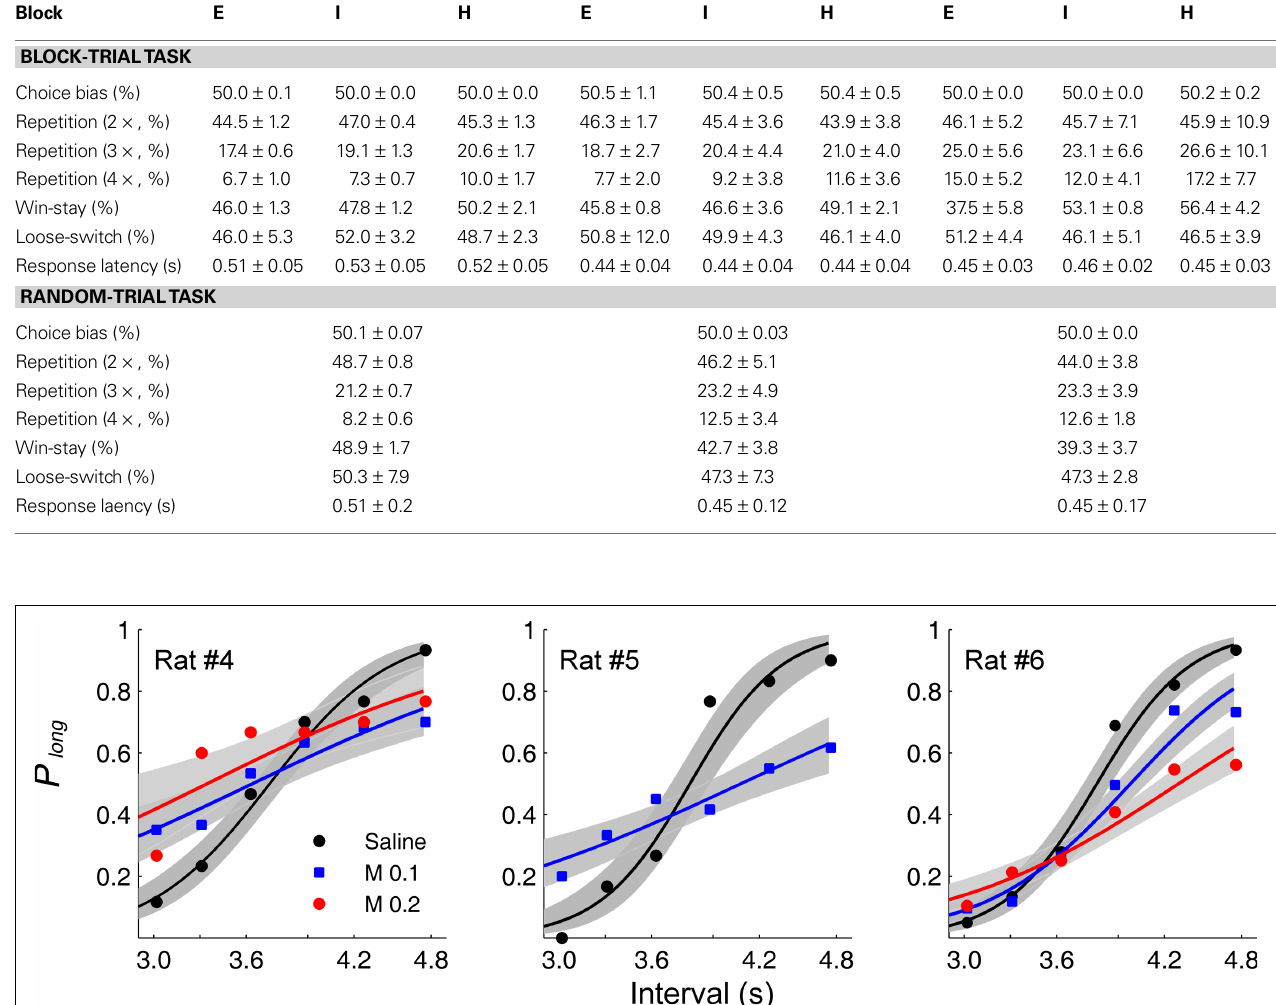
) is plotted against sample interval long